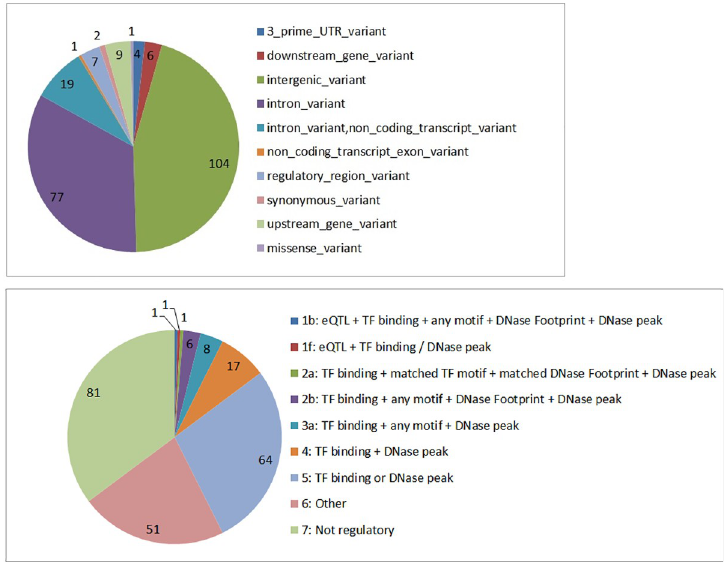
(Delta 3) dependency analysis. a ) Distribution of candidate SNPs across the functional locations based on VEP annotation. Most of the SNPs are located in non-coding locations, i.e., intronic and intergenic regions of the genome. b ) The RegulomeDB score for the candidate SNPs. The lower the score, the more likely it is that a SNP has a regulatory function. eQTL = expression Quantitative Trait Loci; TF = Transcription